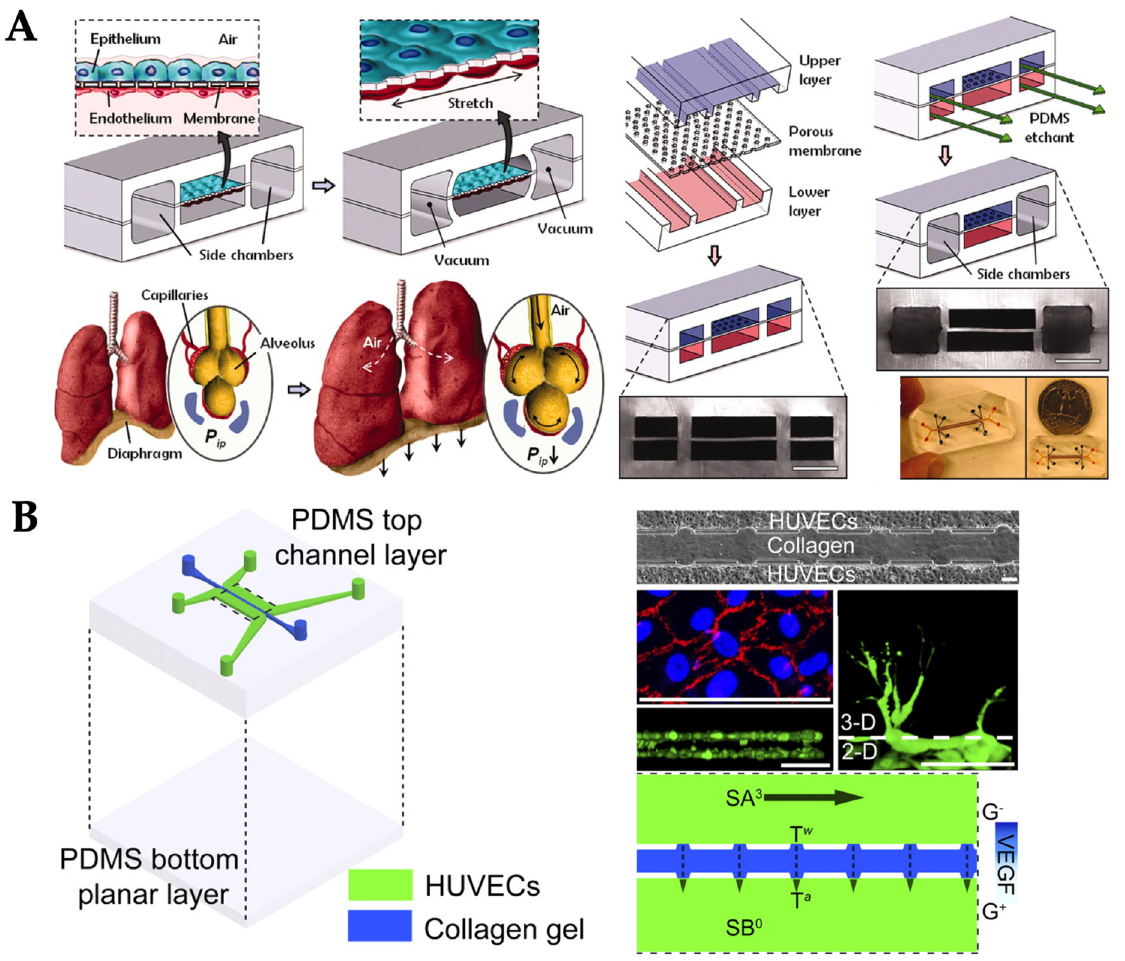
Figure 8. Examples of OOC systems with multiple types of mechanical stimuli. ( A ) Lung-on-chip. Reproduced with permission from Reference [64]. ( B ) Endothelial cells-on-chip. Reproduced with permission from Reference [66].